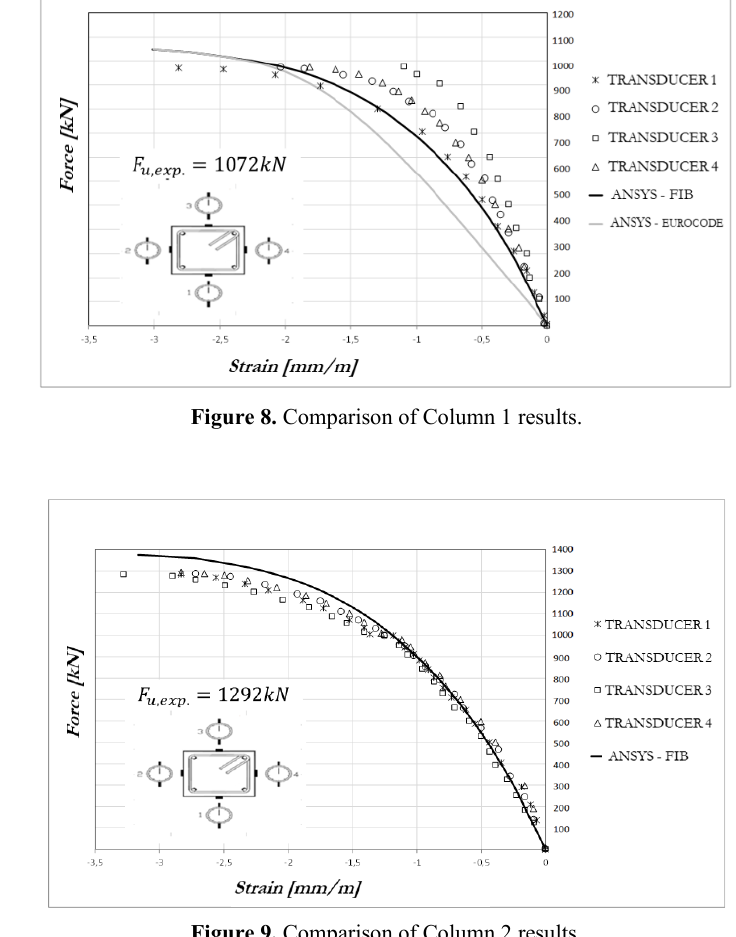
Figure 9. Comparison of Column 2